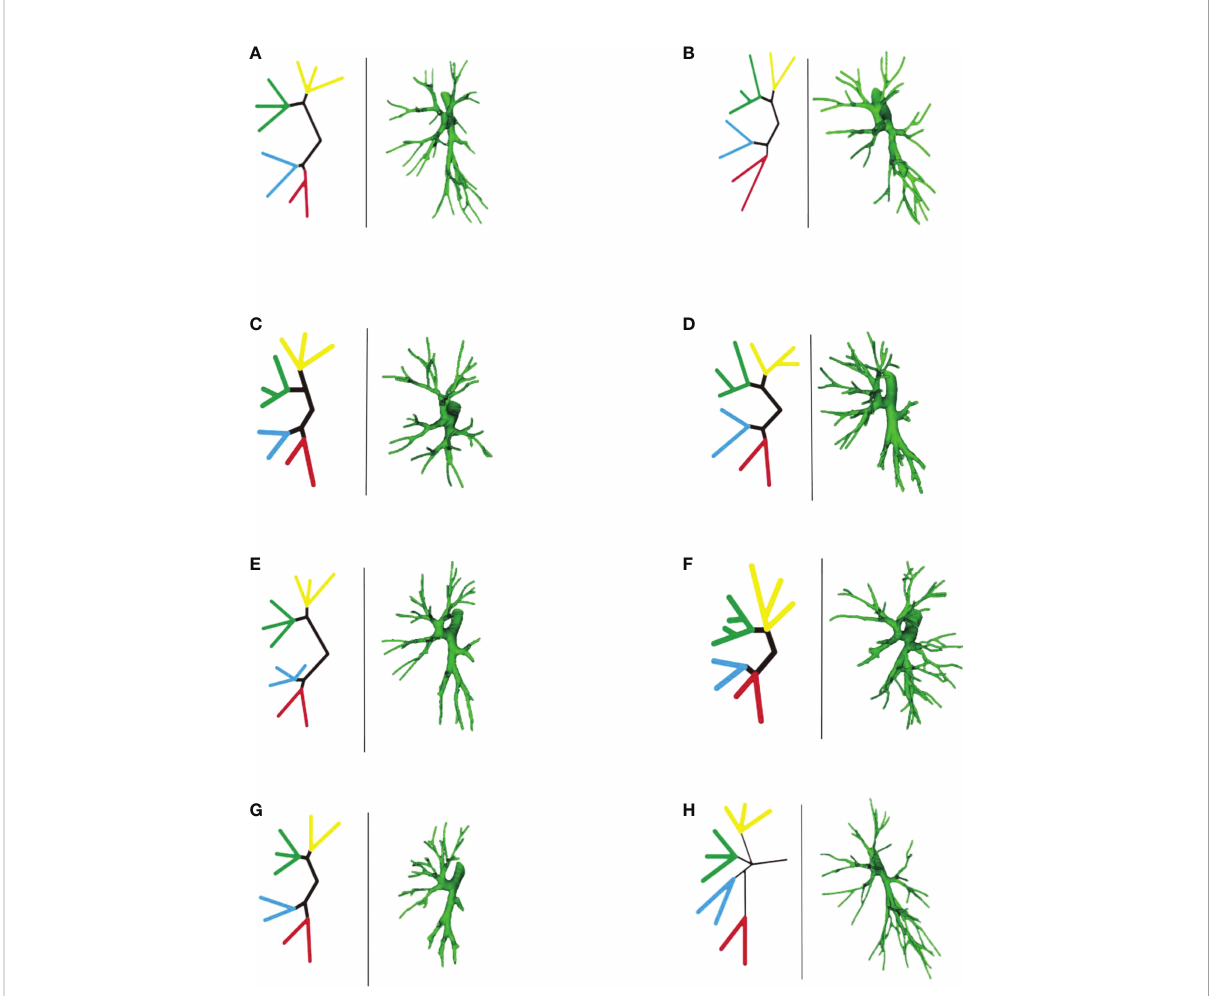
FIGURE 18 (A-H) Left part is a simpli fi ed schematic diagram of the left upper lobe bronchus, and the right part is the speci fi c reconstruction of the left whole lung